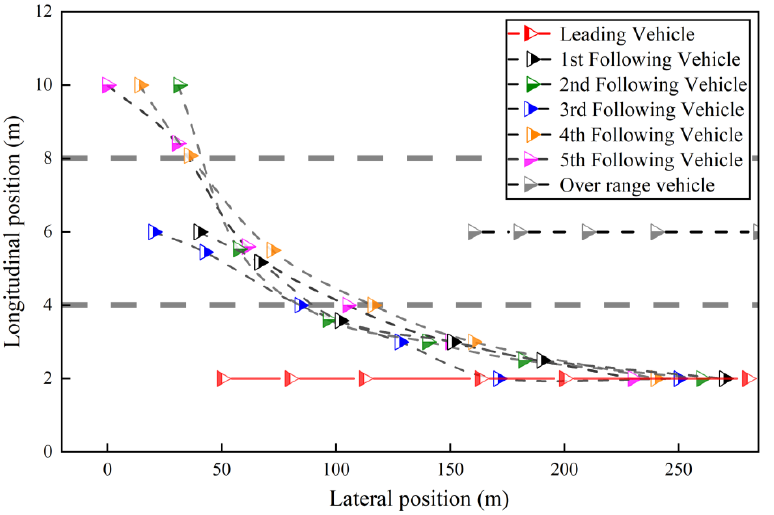
Figure 5. The trajectories of the connected and automated vehicles (CAVs) during the platoon formation process (scenario I).